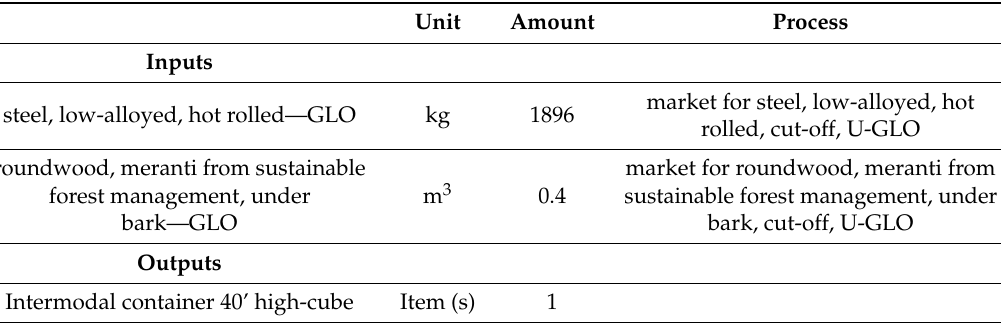
Table A7. Manufacturing, Intermodal container 40’ high cube.